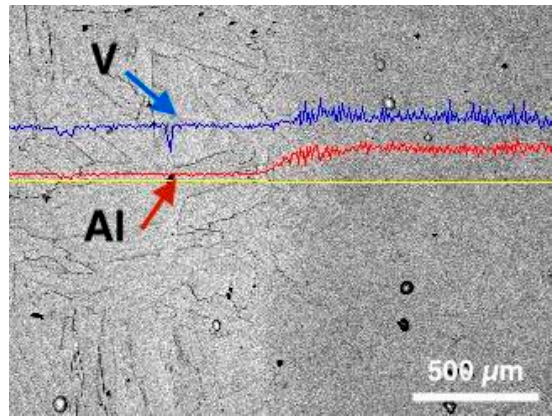
Figure 4. EDX results showing the change of V and Al composition distribution along the transition zone from Ti (left) to Ti64 (right) on the sample.